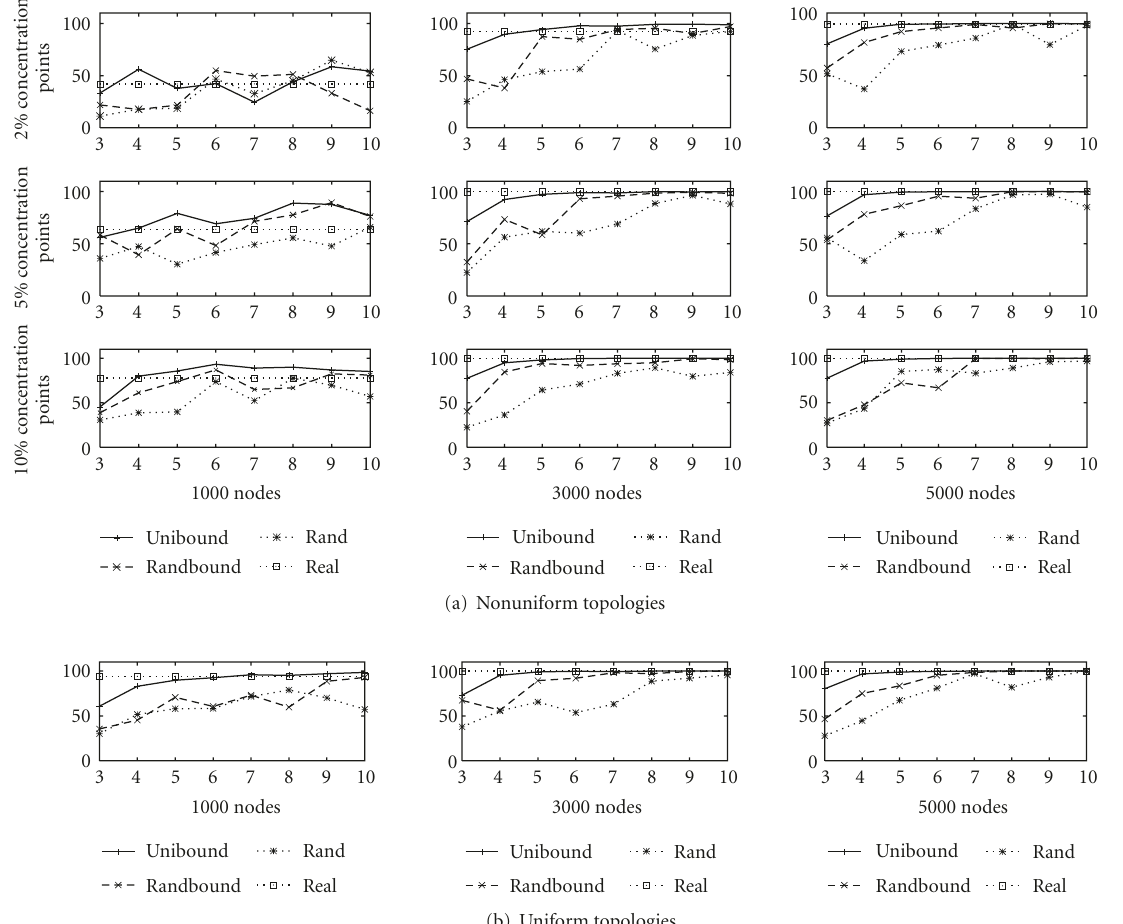
Figure 10: Route computation success rate ( y axis) as a function of number of landmarks ( x axis). Here we observe that the landmark placement strategy used is not negligible but becomes less important as the number of landmarks